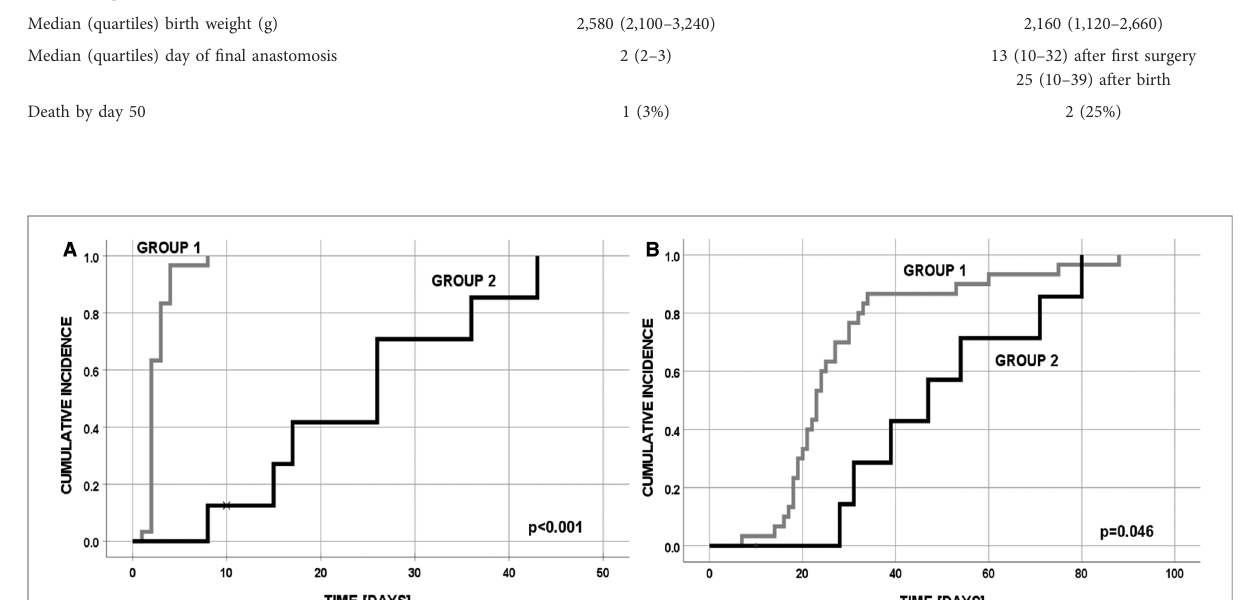
FIGURE 1 Cumulative incidence in group 1 and 2: ( A ) fi nal EA anastomosis; ( B ) discharge from the hospital (one patient in group 2 has died after fi rst operation at day